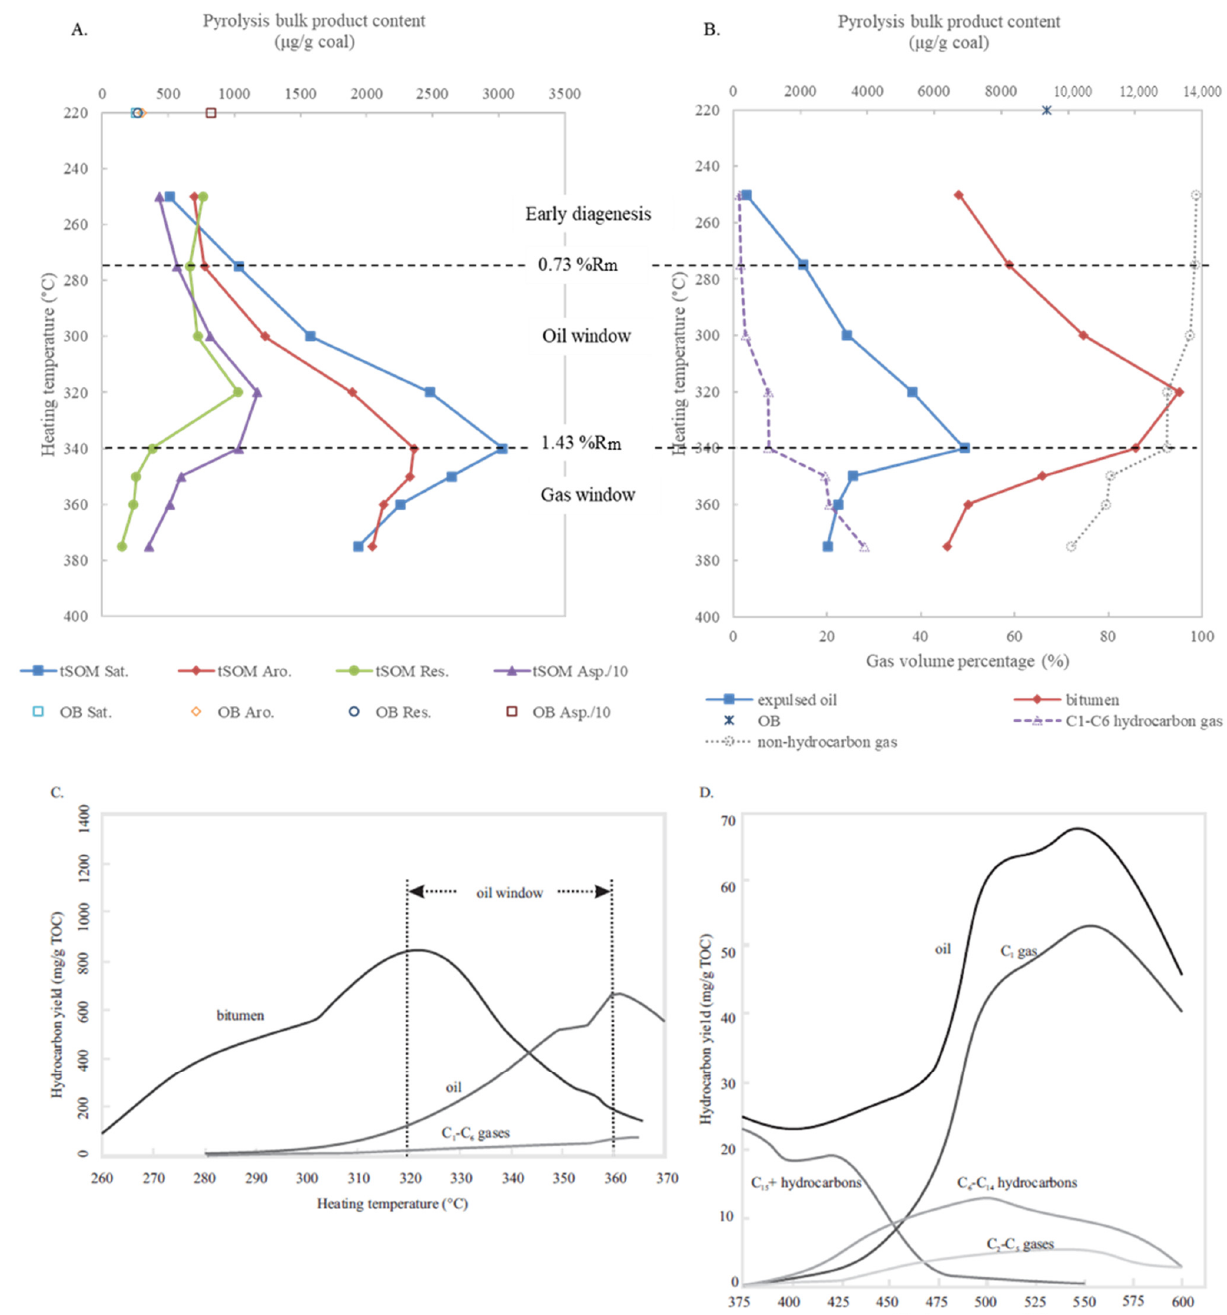
Figure 2. ( A ) Changes in saturated hydrocarbons, aromatic hydrocarbons, resins and asphaltenes (SARA) compositions ( μ g/g coal) in the original bitumen (OB) and the total soluble organic materials (tSOMs); ( B ) Bitumen yield ( μ g/g coal) from the original coal, expelled oil and extractable bitumen contents ( μ g/g coal) in the tSOMs, and hydrocarbon and nonhydrocarbon gas percentages (%) generated under different heating target temperatures (own elaboration); ( C ) Yields of bulk hydrocarbons generated under different heating target temperatures 2015. ( D ) Yields of total expulsed oil and various compound classes under different heating target temperatures of semi-open pyrolysis of a preheated immature shale core to 350 °C from the Bohai Bay Basin, China, after Shao et al. [48]. In ( A , B ), the OB was assigned a heating temperature of 220 °C for visualization purpose only. Asphaltene content was divided by 10 to be displayed on the same scale as the other SARA fractions. Sat.: saturated hydrocarbons; Aro.: aromatic hydrocarbons; Res.: resins; Asp.: asphaltenes.